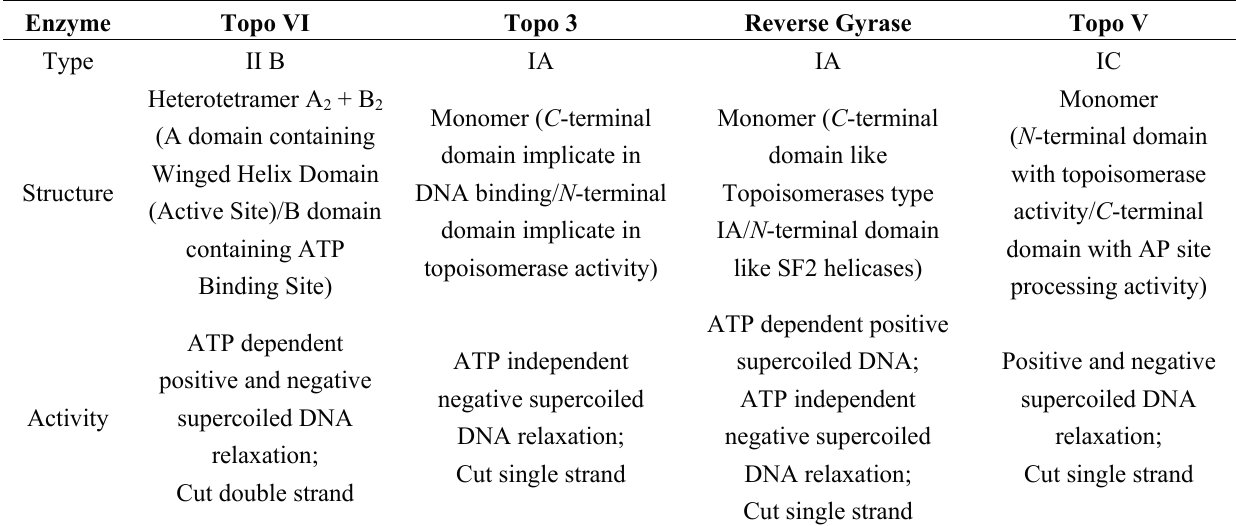
Table 2. Features of DNA topoisomerases of hyperthermophilic archaea. Type IA enzymes are shared by almost all archaea, bacteria and eukaryotes; type IIB are present in all archaea and some plants; reverse gyrase is found only in hypethermophilic archea and bacteria; type IC is restricted to M. kandleri